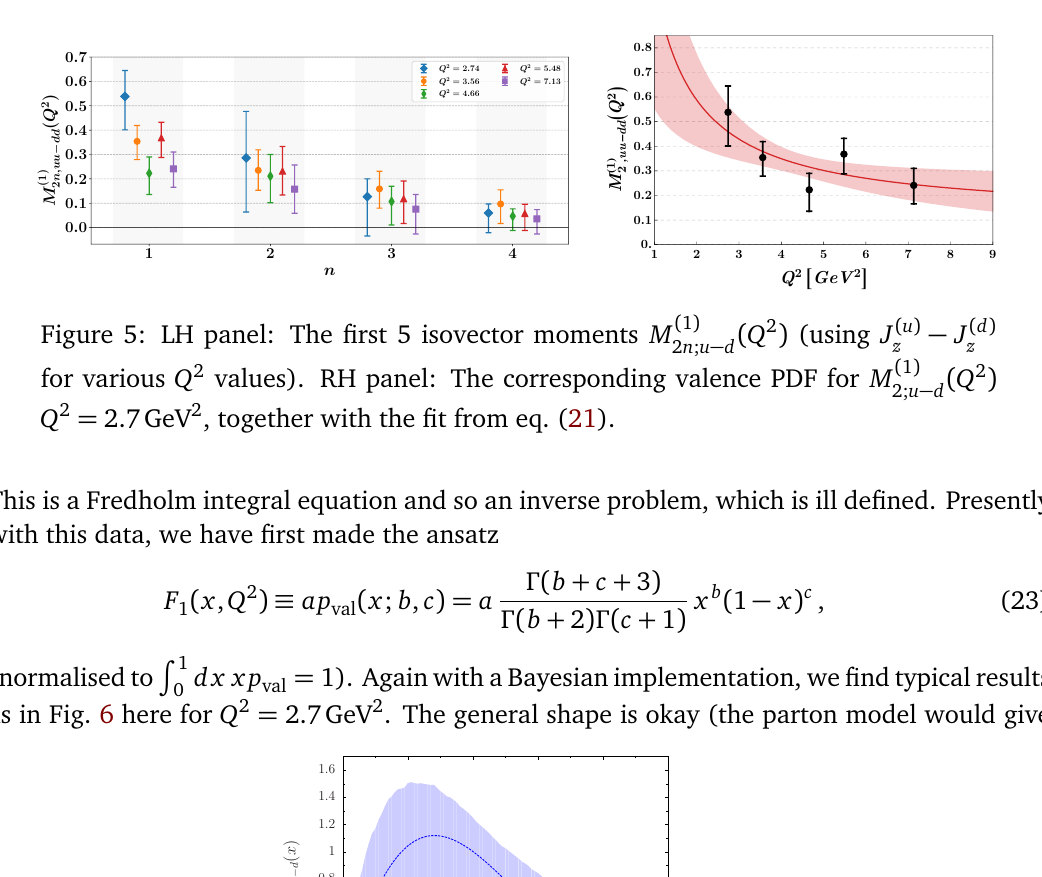
Figure 6: The valence PDF, p